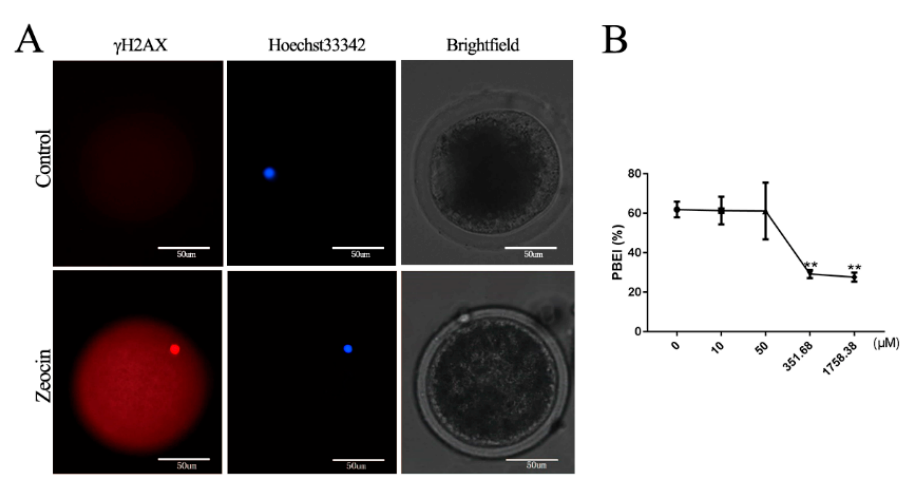
Figure 3. Effects of DNA double-strand breaks (DSBs) induced by Zeocin on bovine oocyte in vitro maturation (IVM): ( A ) immunofluorescence of γ H2AX in the oocytes after bovine cumulus–oocyte complexes (COCs) treated with 10 μ M Zeocin for 2 h, scale bar = 50 μ M; ( B ) polar body excretion (PBEI) (%) of oocytes after bovine COCs were treated with different concentrations of Zeocin (10, 50, 351.68 or 1758.38 μ M) for 22 h. ** indicates p < 0.01.